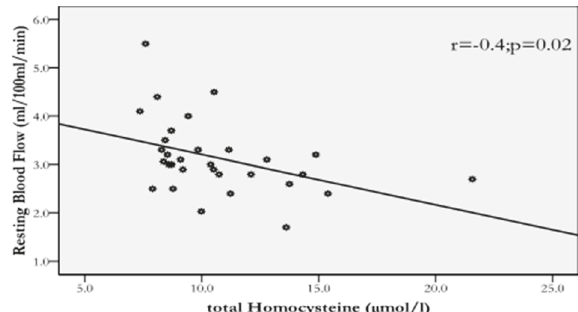
Figure 1: The relationship of total homocysteine level with resting blood flow in the patients ( 𝑟 = −0.4 ; 𝑝 = 0.02 ).